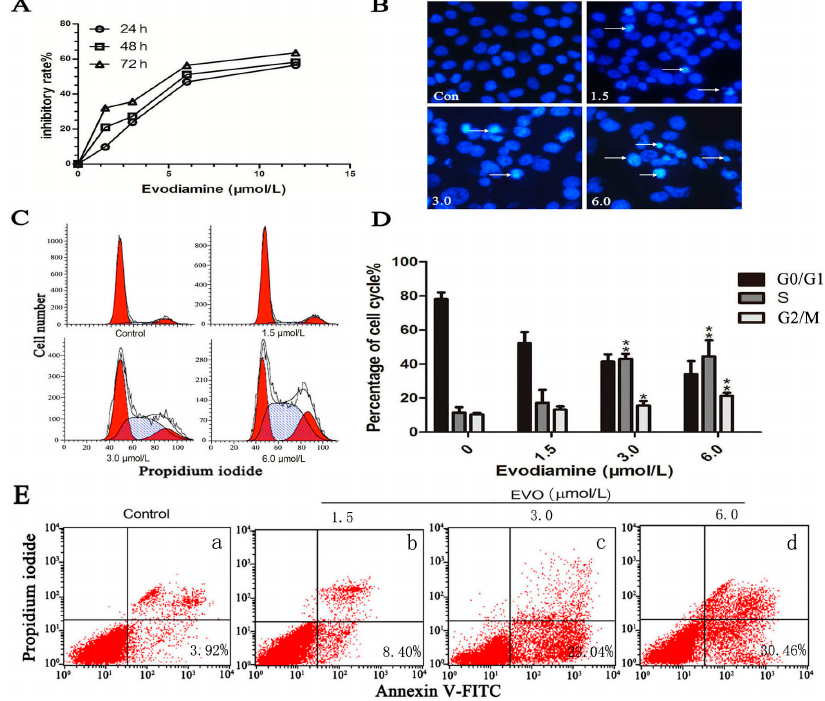
Figure 1. EVO shows anticancer effects in HCT-116 cells. ( A ) Cells were exposed to EVO at the indicated doses for 24, 48, and 72 h, and cell viability was assessed by the CCK-8 assay; ( B ) The nuclear morphological changes of apoptotic cells were observed after Hoechst staining. Arrows show pathological changes of apoptosis (original magnification, 400×); ( C , E ) HCT-116 cells were treated with various concentrations of EVO for 48 h, cell cycle arrest and apoptosis rate were analyzed by flow cytometry; and ( D ) * p < 0.05, ** p < 0.01 compared to control (0 µ mol/L of EVO). Note: a : control,